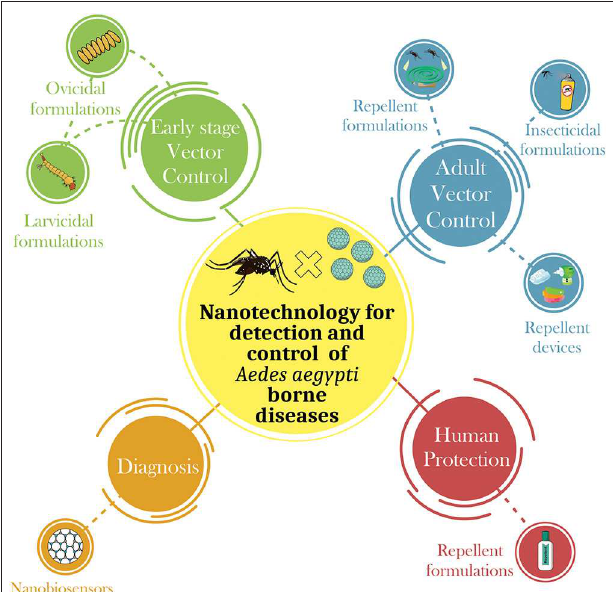
FIGURE 1 | Summary of the main applications of nanotechnology in the control of Aedes aegypti- borne diseases. There are four main areas where nanotechnolgy can be connected: (i) Early stage vector control —The nanodevices for the control of Aedes aegypti can be developed in order to control this pest in its different stages of life. Many studies have developed nanodevices to control the early stages of mosquitoes, i.e., products that exhibit ovicidal and/or larvicidal activity; (ii) Adult vector control— adult insect control is also highly studied form of control through the development of nanoformulations that exhibit larvicidal and/or repellent activity; (iii) Human protection— following the recent epidemic of arboviruses transmitted by Aedes aegypti , many studies have focused on the development of forms of immunization of humans through the development of nanovaccines, and (iv) Diagnosis— the development of nanobiosensors that quickly detect the presence of arboviruses in the host, thus expediting the decision for the most effective